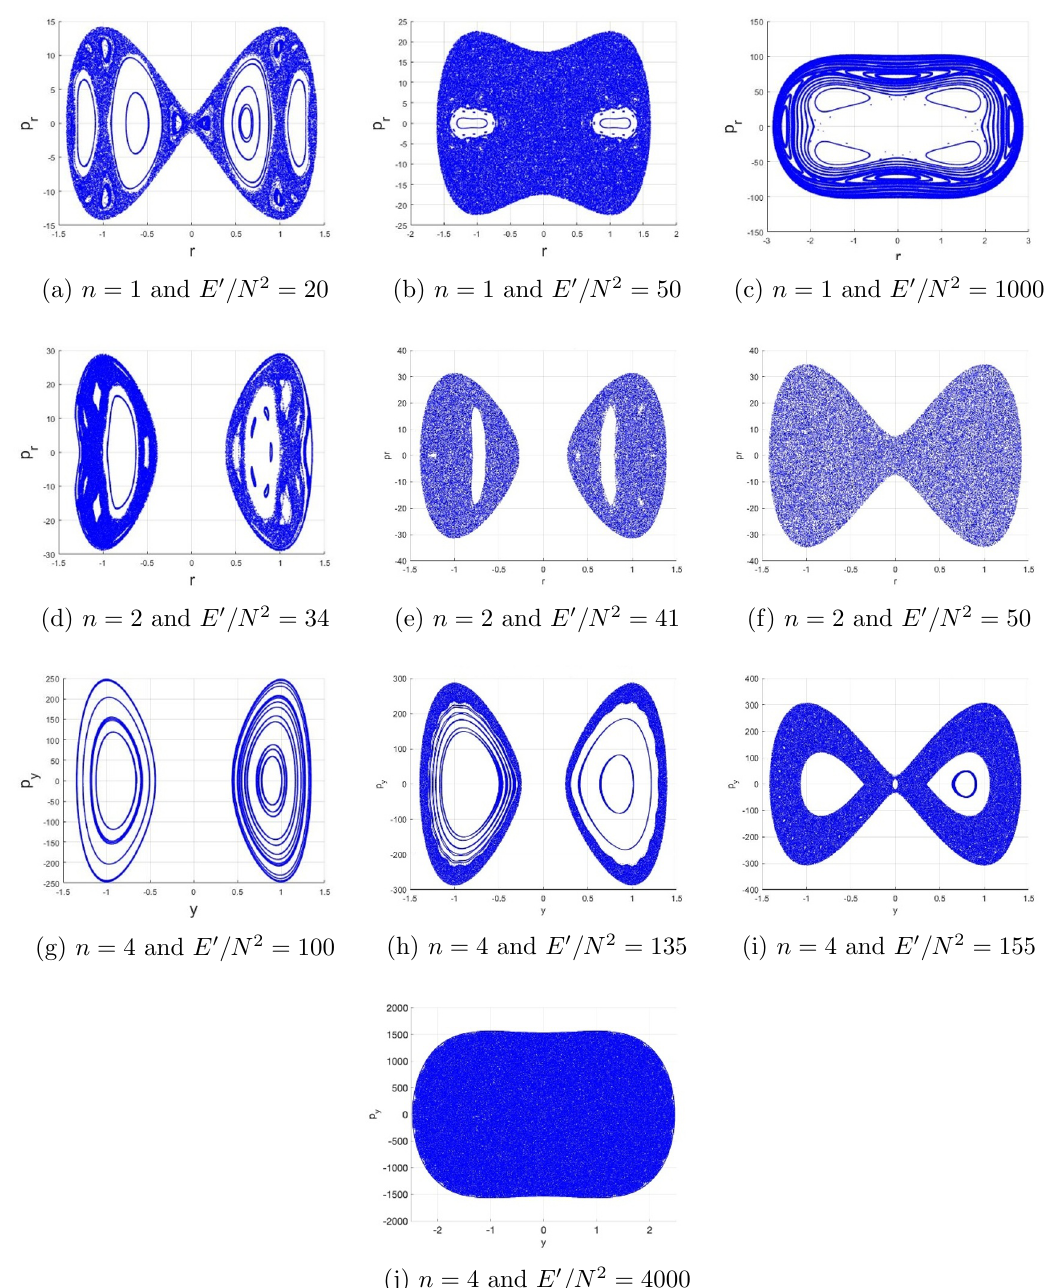
Figure 2. Poincar(cid:19)e sections (plots are given w.r.t. the shifted energies E 0 = E + j V